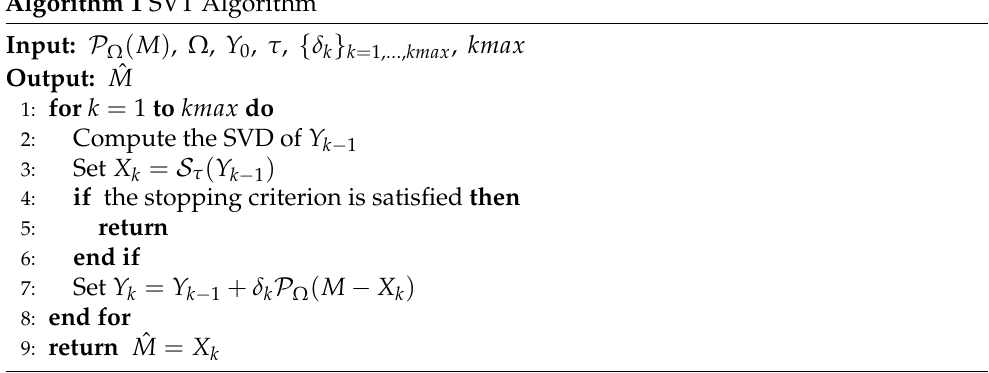
Algorithm 1 SVT